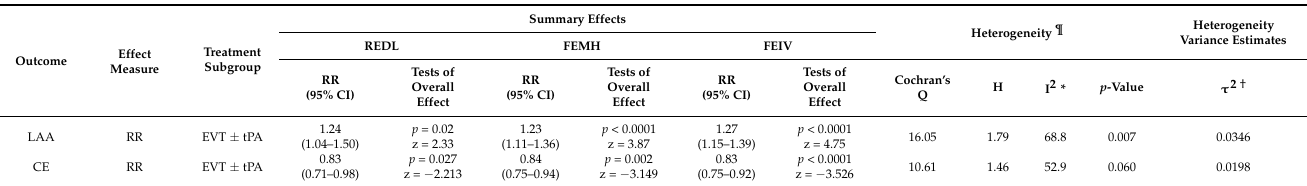
Table 3. Summary effects and heterogeneity obtained from the meta-analysis of the association of pre-intervention collateral status with stroke